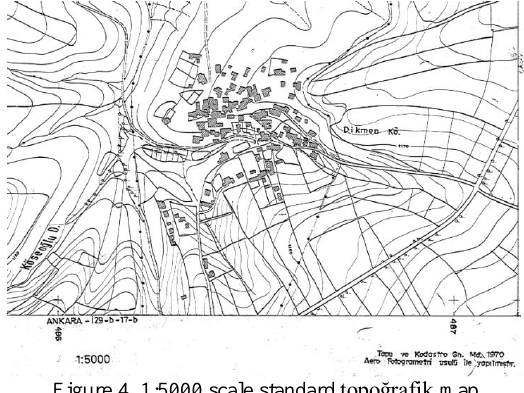
Figure 4. 1:5000 scale standard topoğrafik map Aerial photography for the production of various scale photogrammetric mapping during 1990-2000 were done. In this context, the analog system, the location of production in 1996, replaced by the analytical systems (http://www.tkgm.gov.tr).